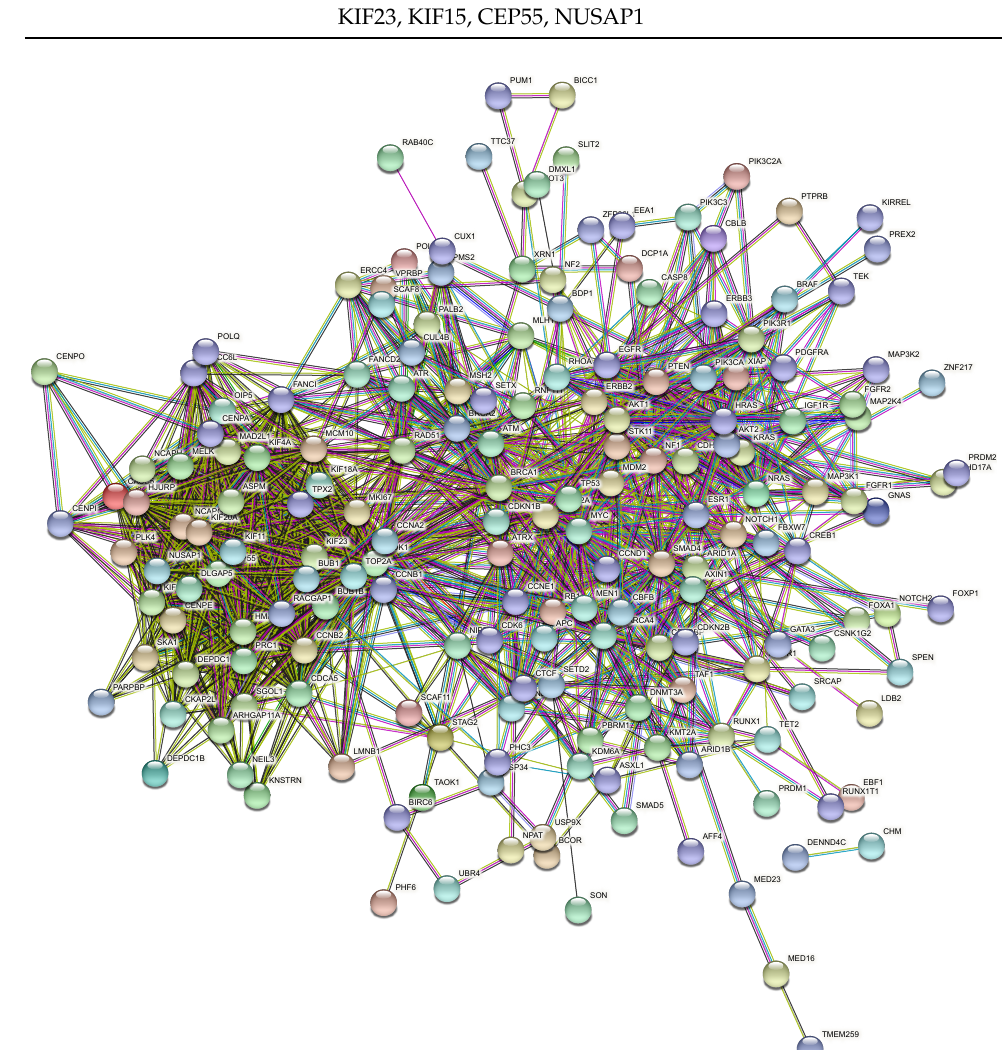
Figure 3. The protein–protein interaction network of breast cancer-relevant genes. Node represents gene, and edge represents the interaction between two